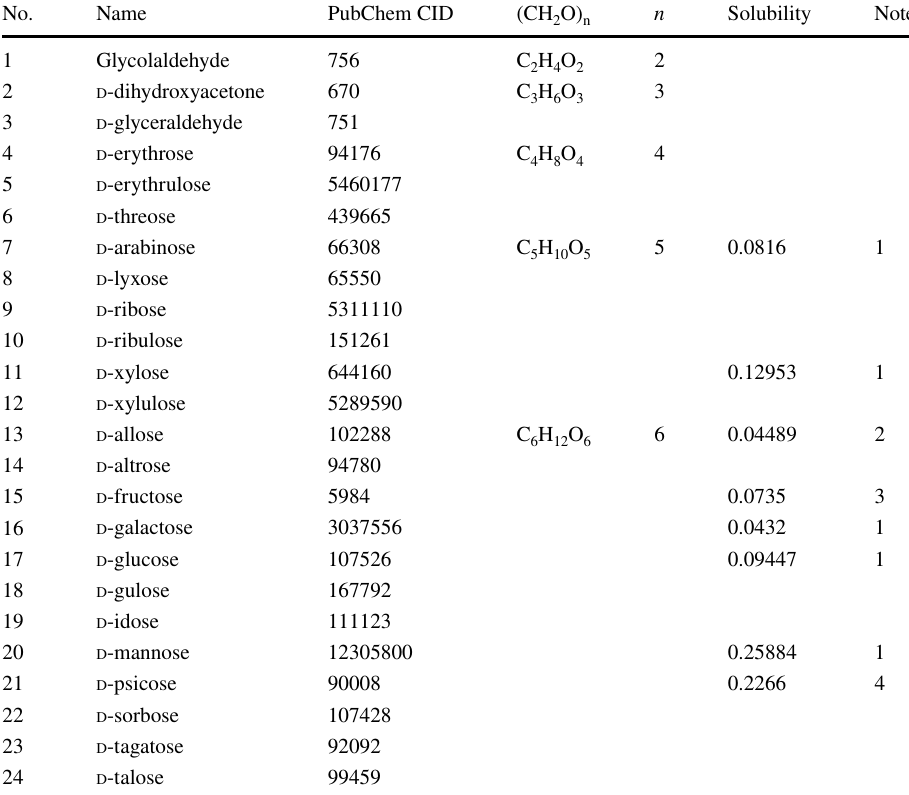
experimental solubilities in mole fraction (mol/mol) at IUPAC STAP conditions along with identifiers of their chemical structure (PubChem